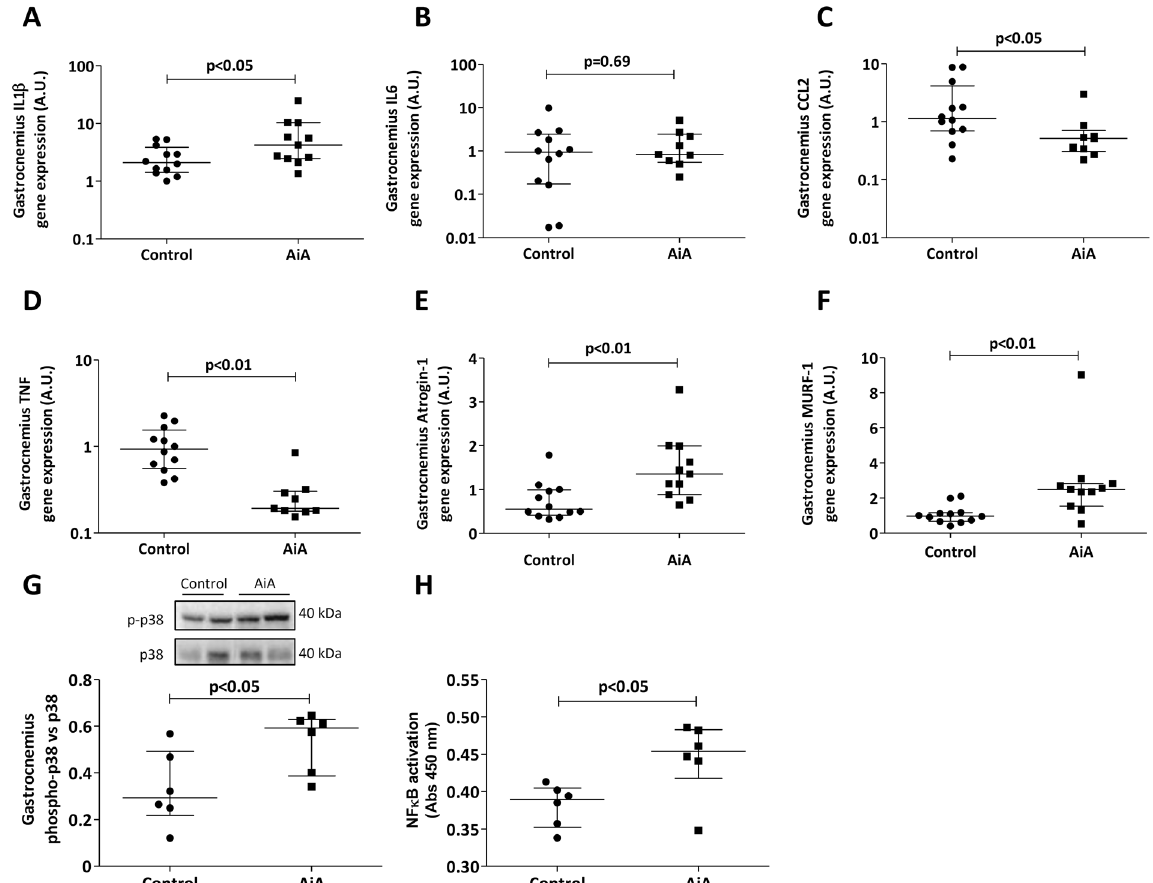
Figure 5. Pro-inflammatory mediators and atrogenes. Gene expression of control and AiA rabbits normalized to endogenous control in gastrocnemius. Data represent individual values and medians with IQRs are also indicated (n = 6 rabbits per group, both limbs of each rabbit are represented) for IL-1 β ( A ), IL-6 ( B ), CCL-2 ( C ), TNF ( D ), atrogin-1 ( E ) and MuRF1 ( F ). ( G ) Protein expression of p38 MAPK. Data are expressed as arbitrary densitometric units (A.U.) and normalized relative to the expression of phosphorylated p38 MAPK. Representative cropped blot of two animals of each group are shown, control and AiA, respectively. Full-length blot is presented in Supplementary Figure 2. ( H ) Active protein levels of NF- κ B measured by enzyme linked immunoabsorbant assay. Graphs show individual values and medians with IQRs are also indicated (n = 6 rabbits per group). IL = interleukin, CCL-2 = C-C Motif Chemokine Ligand 2, TNF = tumor necrosis factor, MuRF1 = muscle RING-finger